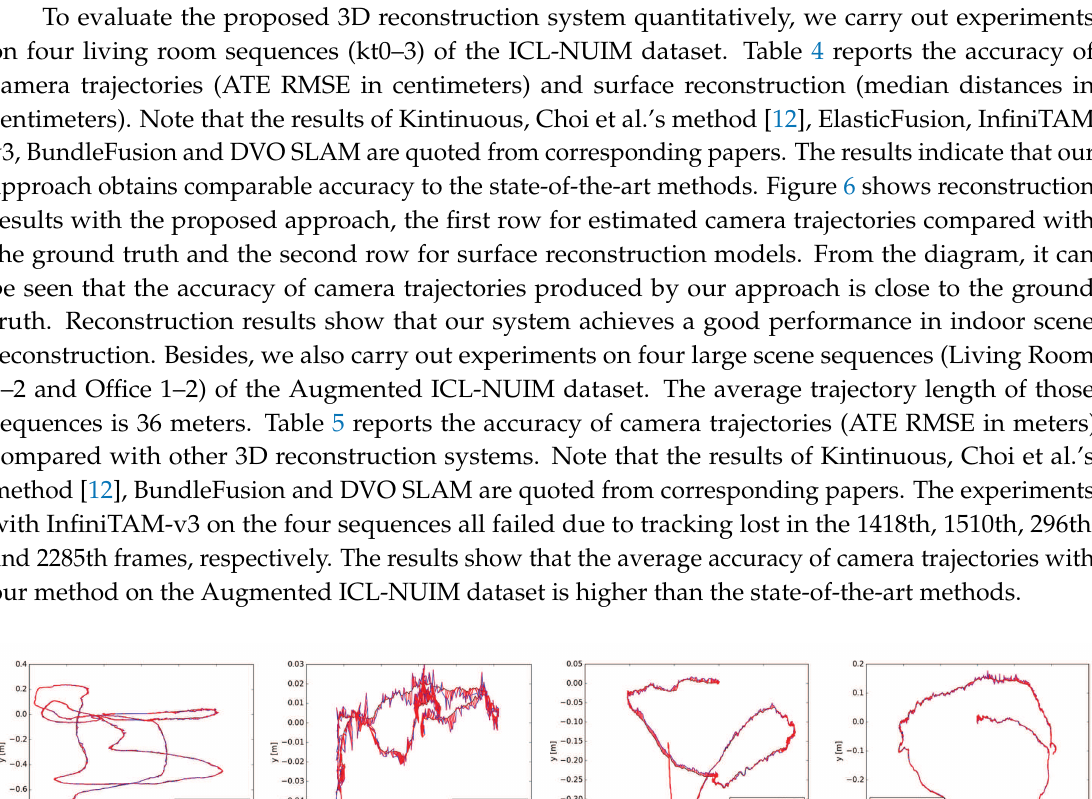
Figure 5. Comparison of the reconstruction results for a desk scene before and after camera view selection. Note that the mesh model is fused by standard TSDF.